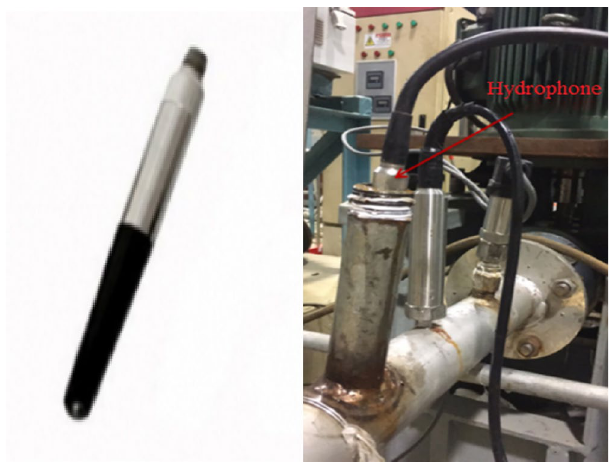
Figure 10. Hydrophone and installation